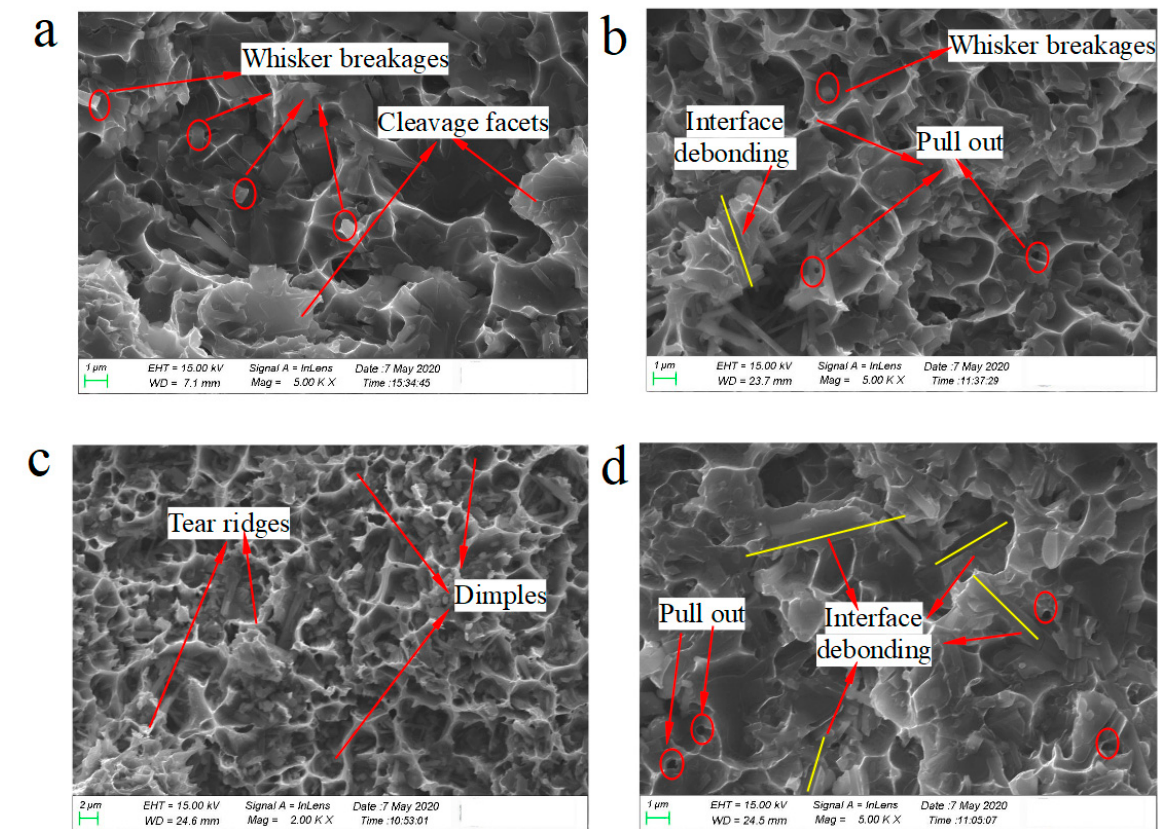
Figure 11. Scanning electron microscopy images of the ABOw/Al–12Si composite after creep at ( a ) 300 °C and 160 MPa, ( b ) 350 °C and 90 MPa, ( c ) 400 °C and 70 MPa (lower magnification), ( d ) 400 °C and 70 MPa (higher magnification).